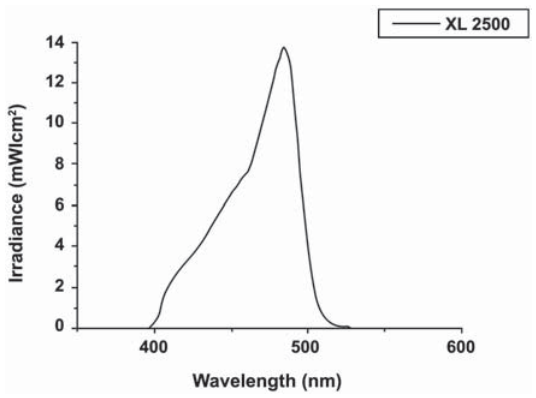
FIGURE 2- Spectral distributions of XL 2500